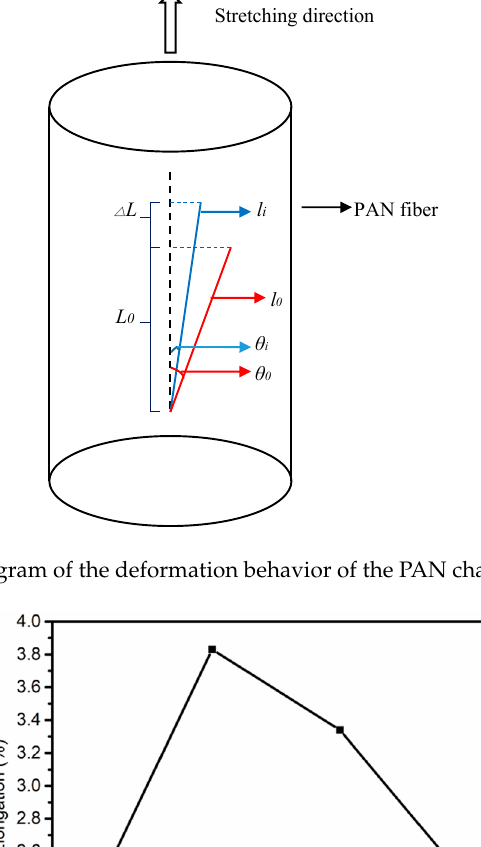
Figure 7. Schematic diagram of the change of crystallinity and the variation of chain segment in amorphous zone of fibers.